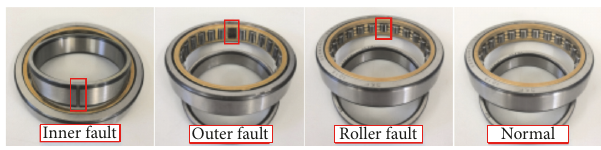
Figure 4: Faults in the intershaft